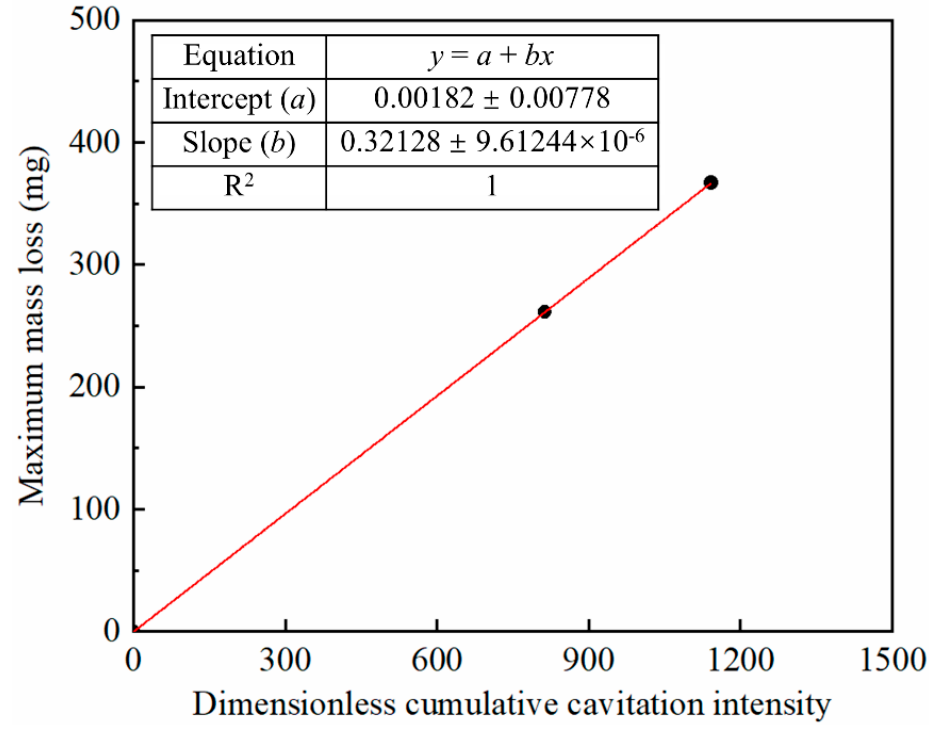
Figure 10. Fitting curve of dimensionless cumulative cavitation intensity and maximum mass loss.